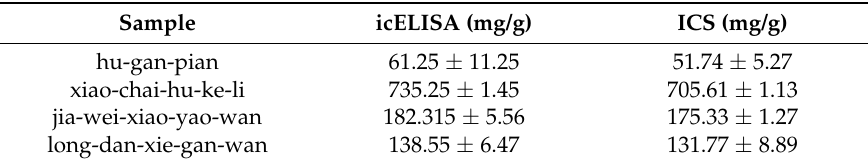
Table 4. Samples assayed by ICS and